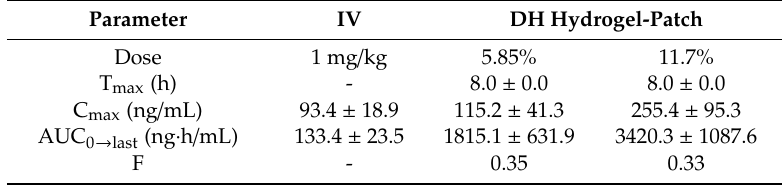
Table 5. Donepezil hydrochloride (DH) pharmacokinetic parameters after intravenous (IV) injection or application of DH hydrogel-patches to hairless rats. Data are expressed as the mean ± standard deviation ( n =